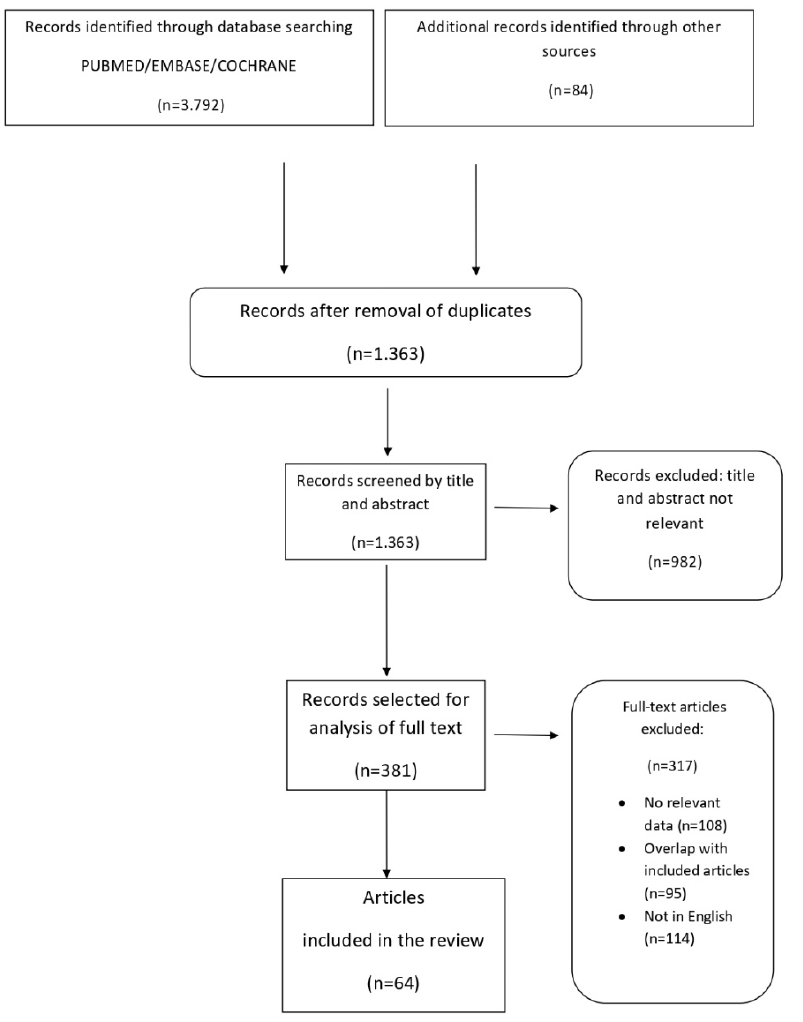
Figure 1. Article selection flowchart.